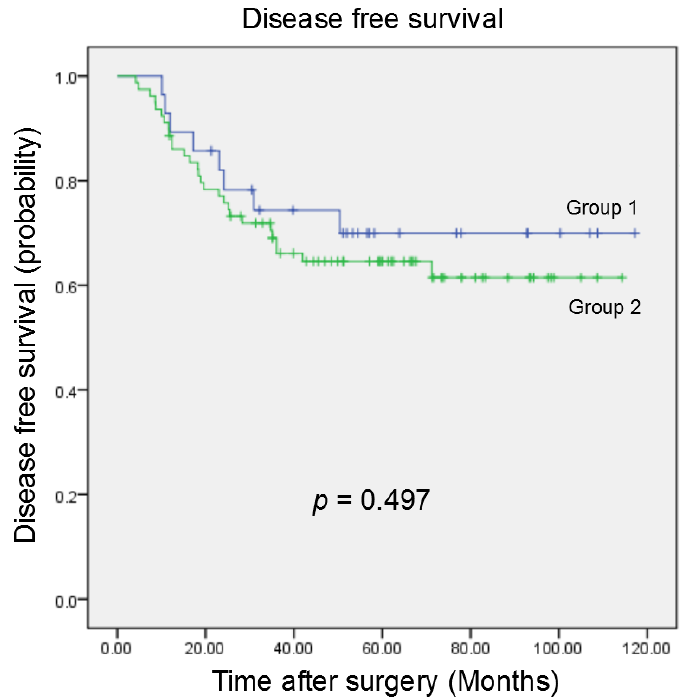
Figure 7. Survival outcomes: The Kaplan – Meier estimation showed no statistical difference in the disease-free survival (DFS) rate between the lobe-specific lymph node dissection (L-SND) and SND groups.